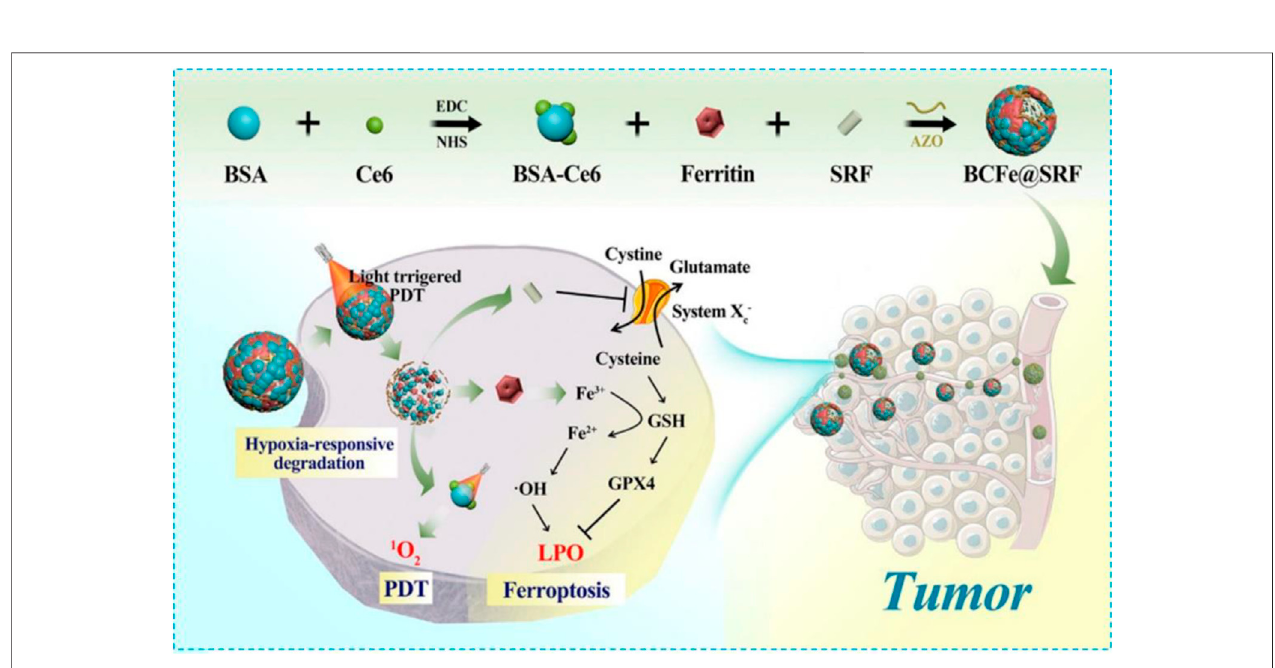
FIGURE 5 | Schematic illustration showing fabrication procedures and antitumor mechanisms of the BCFe@SRF nanoreactor for the synergistic PDT and ferroptosis therapy. Reprinted with permission from Ref. (Wang et al., 2021). Copyright 2021 The Author(s).